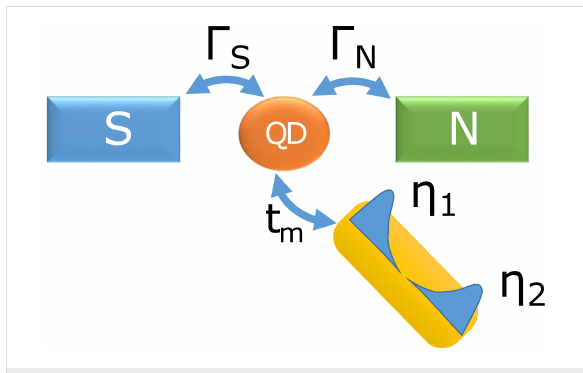
Figure 7: Schematic illustration of the quantum dot (QD) coupled be- tween the metallic (N) and superconducting (S) leads and